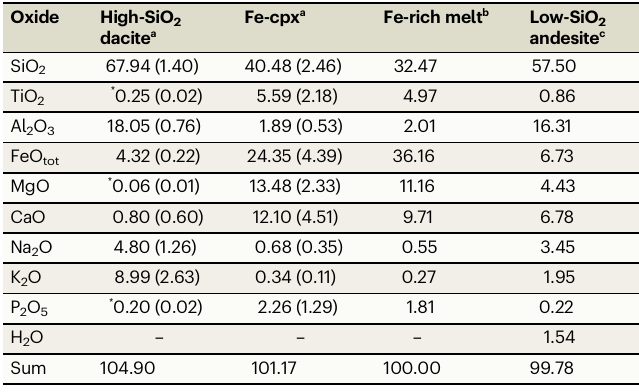
Table 1 | Analysed compositions of immiscible liquids in melt inclusions and model compositions for parent andesite at El